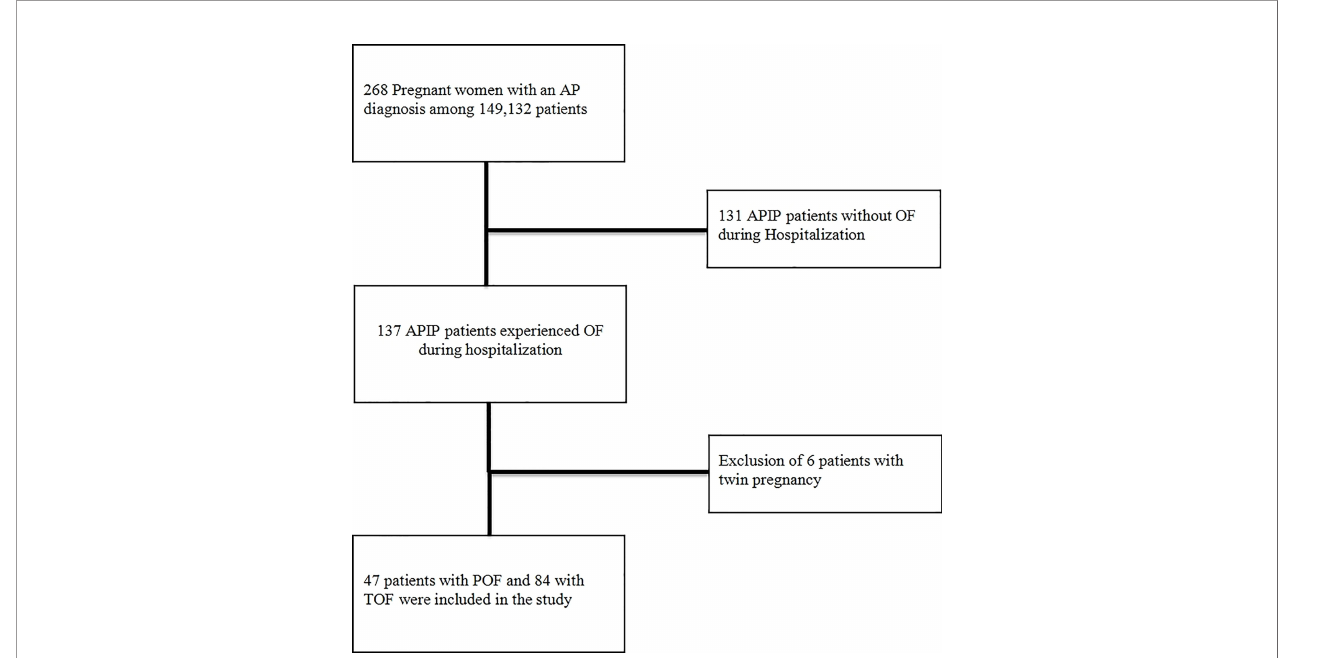
FIGURE 1 | The selection process for patients in a fl ow chart. AP, acute pancreatitis; APIP, Acute pancreatitis in pregnancy; OF, organ failure; POF, persistent organ failure; TOF, transient organ